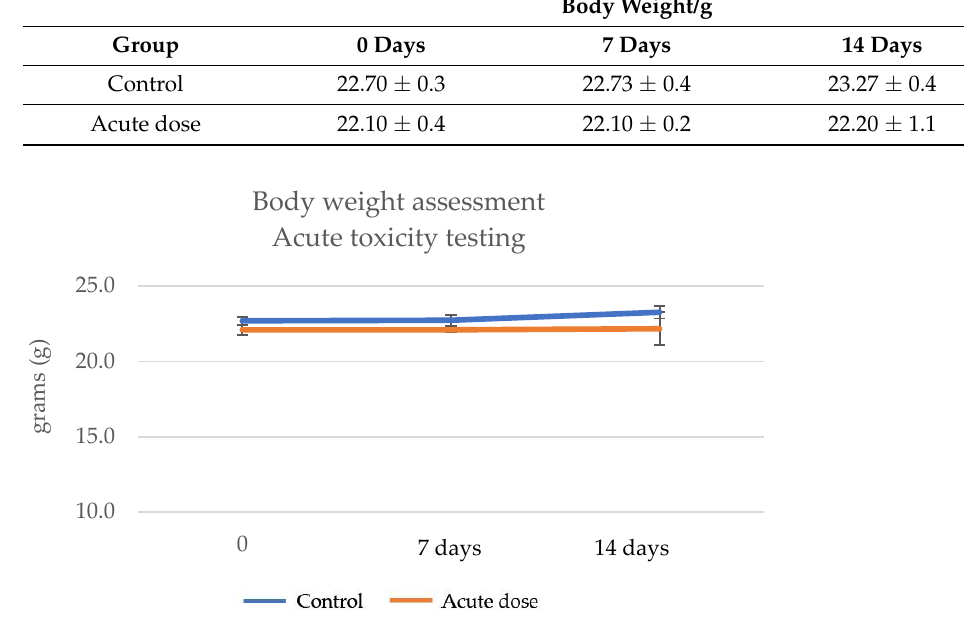
Figure 8. Body weight assessment—acute toxicity testing.